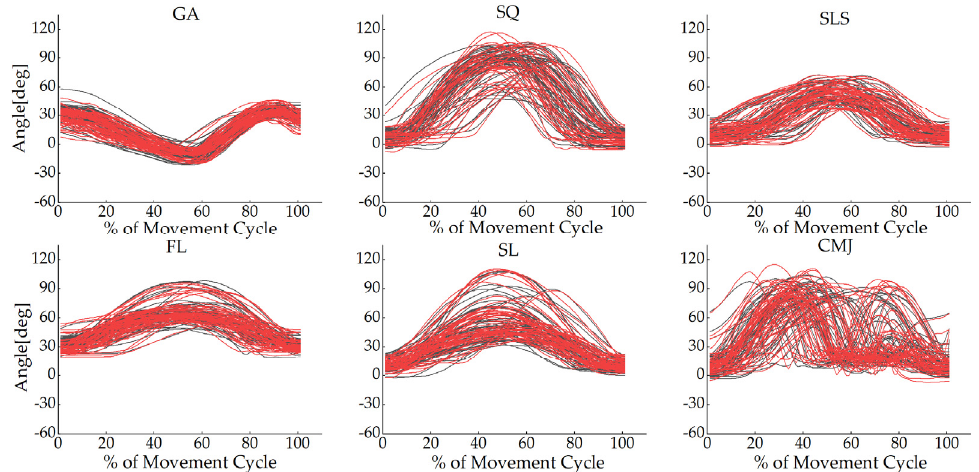
Figure 2. Hip joint angles in the sagittal plane for each participant in all tasks during the movement cycle of the gait (GA), squat (SQ), single-leg squat (SLS), side lunge (SL), forward lunge (FL), and counter-movement jump (CMJ). The black lines represent the OptiTrack system, while the red lines represent the Perception Neuron ® system. The Y -axis depicts joint angles in degrees, while the X -axis depicts the movement cycle in %.